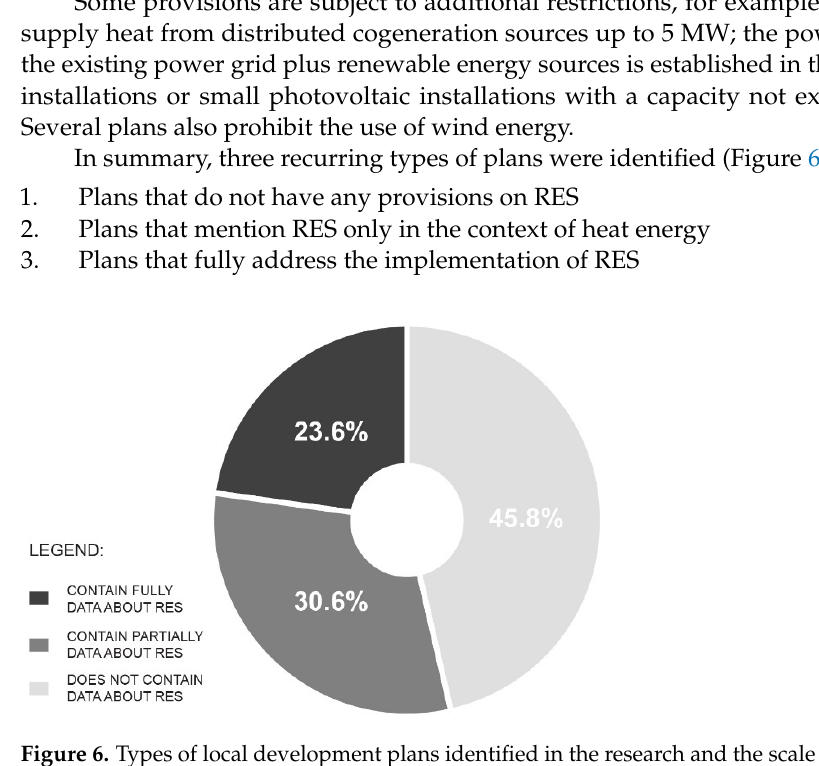
Figure 6. Types of local development plans identified in the research and the scale of their occurrence. Source: own study.